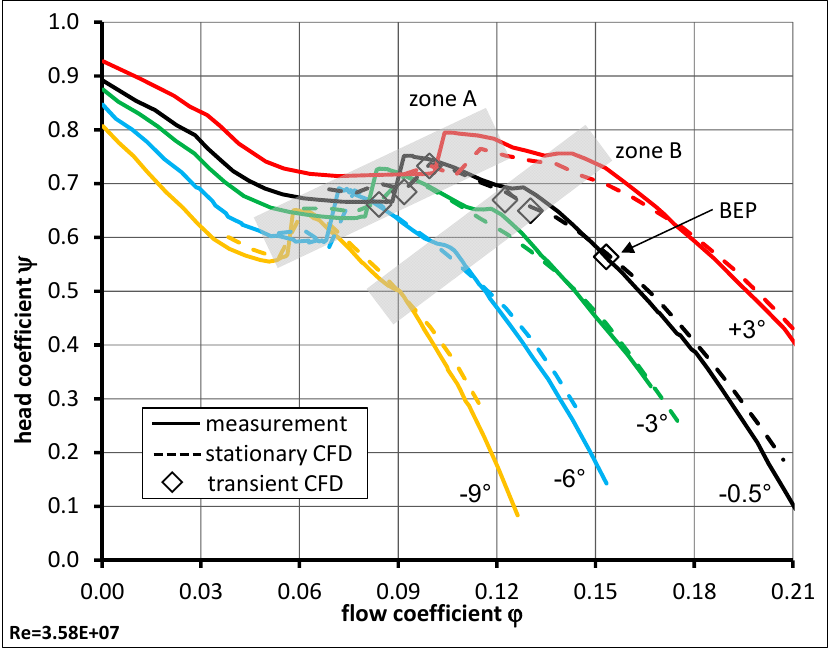
Figure 8. Head curves for variable pitch pump at different positions, CFD (dashed) vs. test rig